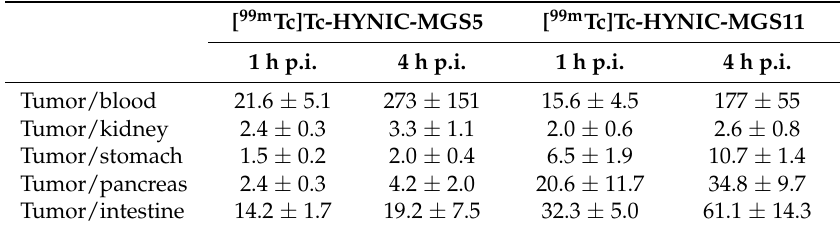
Table 1. Tumor-to-organ activity ratios for A431-CCK2R tumor-xenografts of [ 99m